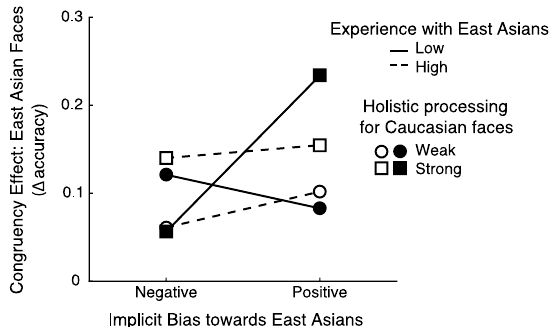
Fig. 3 Mean congruency effect for East Asian faces (∆accuracy), as a function of 1 SD above and below the means of the measures of the magnitude of holistic processing of Caucasian faces (strong vs. weak), experience with East Asian individuals (high vs. low), and implicit bias toward East Asians (positive vs.